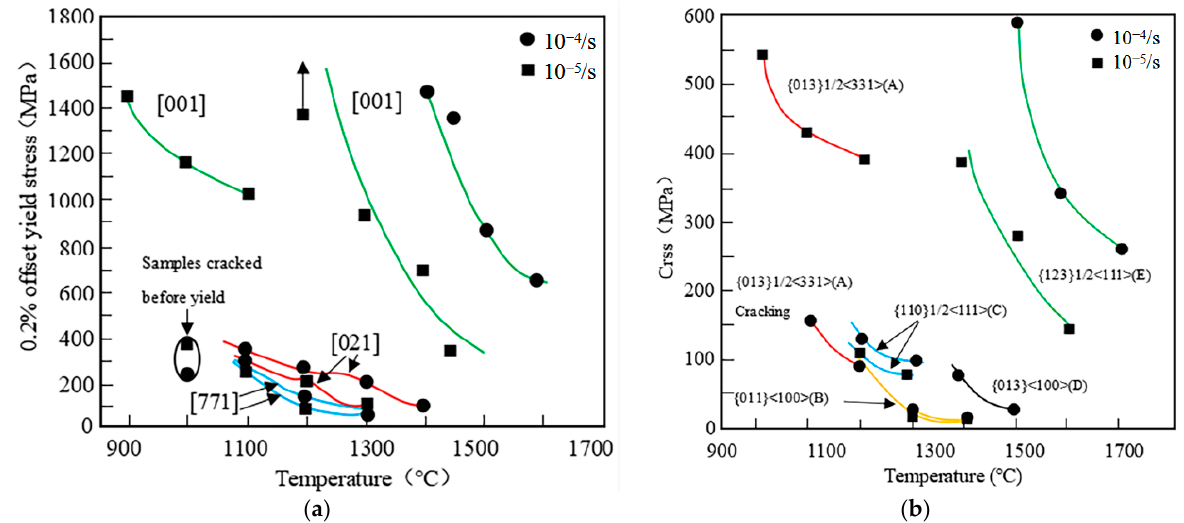
Figure 9. Curves of yield strength and critical shear stress (CRSS) versus the temperature for MoSi 2 single crystals with different orientations at 10 − 4 /s, 10 − 5 /s strain rate: ( a ) curves of yield strength versus temperature MoSi 2 with [001], [021], and [771] orientations; ( b ) critical shear stress (CRSS) versus the temperature for different slip systems [102].